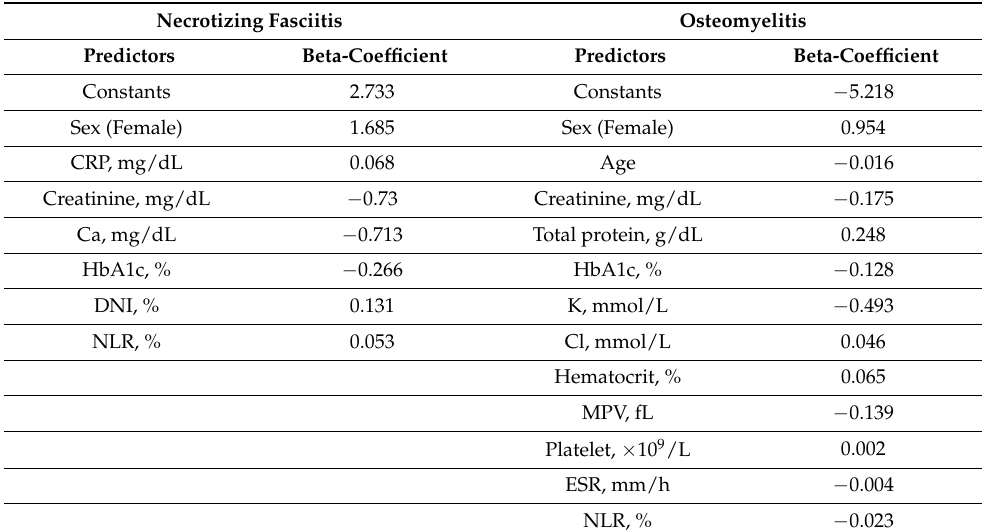
Table 4. Final prediction model for DFU